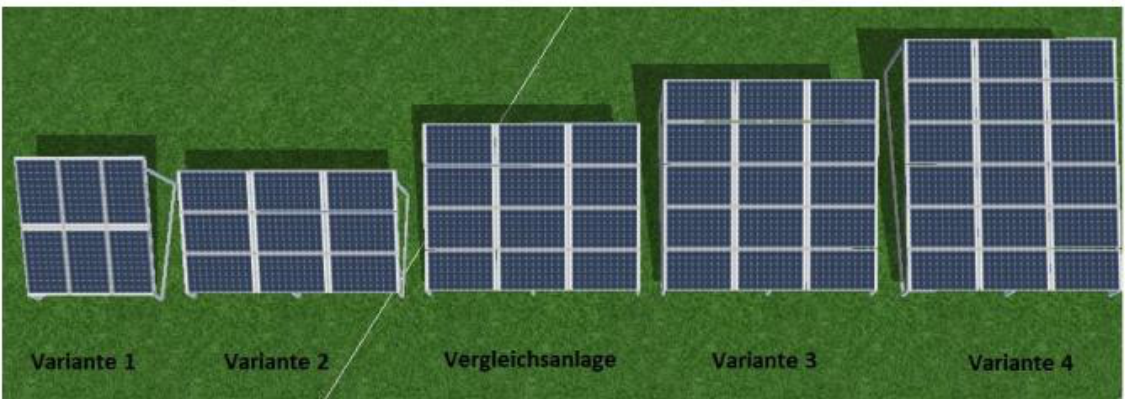
Figure 4. System concepts 1 to 4 and reference [own illustration; in